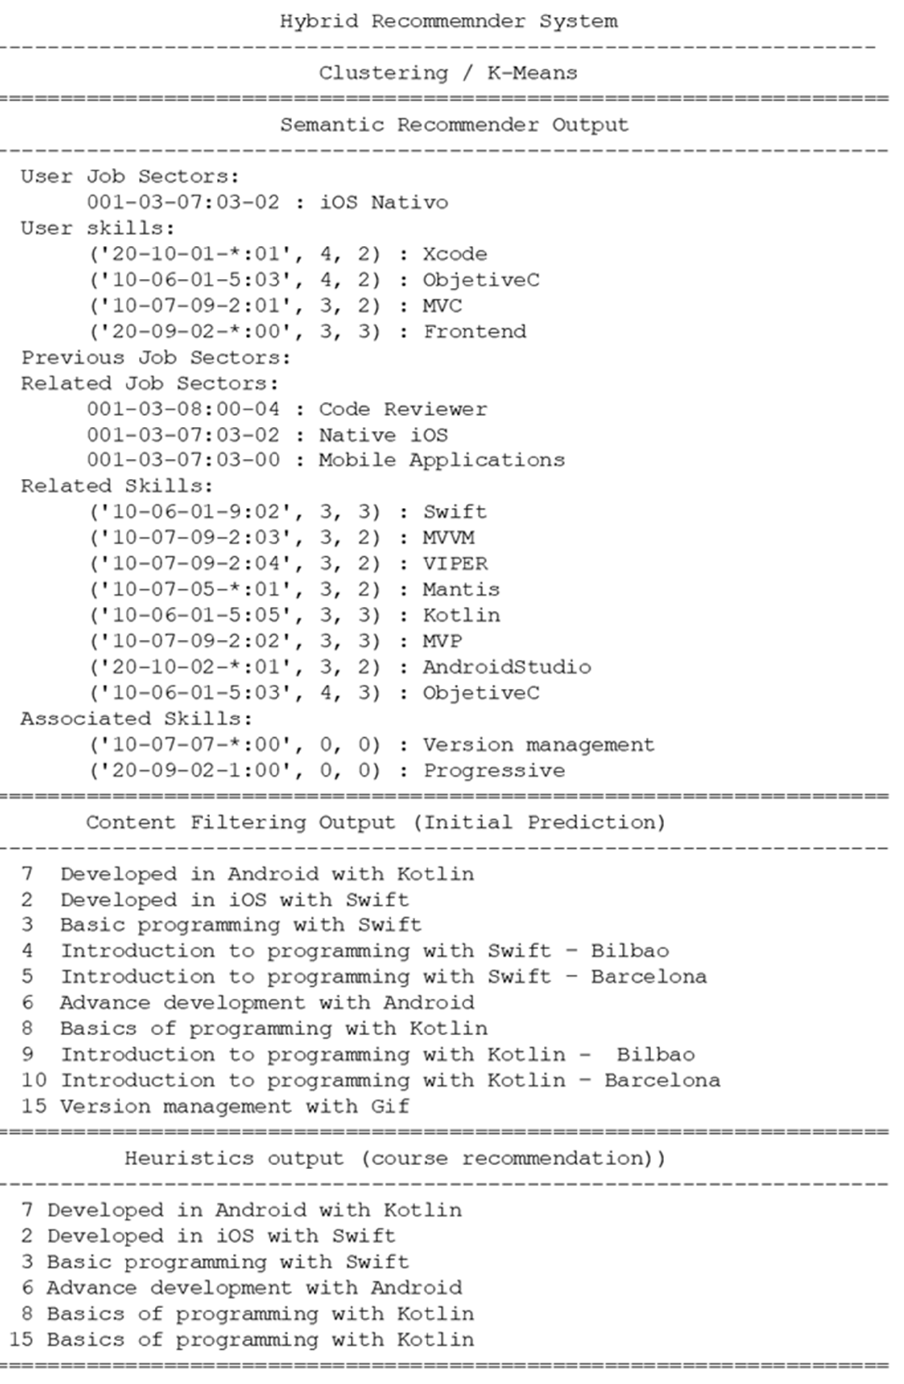
Figure 9. Recommendation system output.